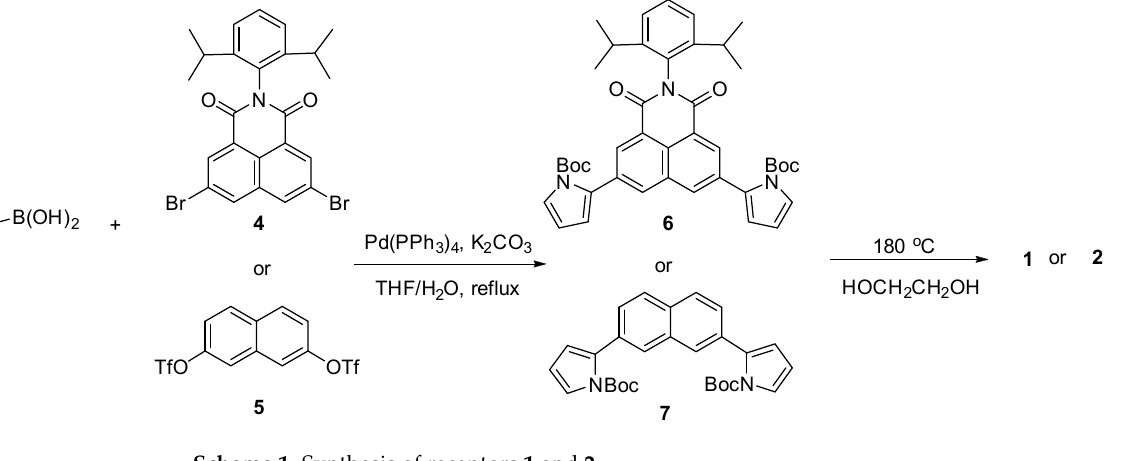
Scheme 1. Synthesis of receptors 1 and 2 .